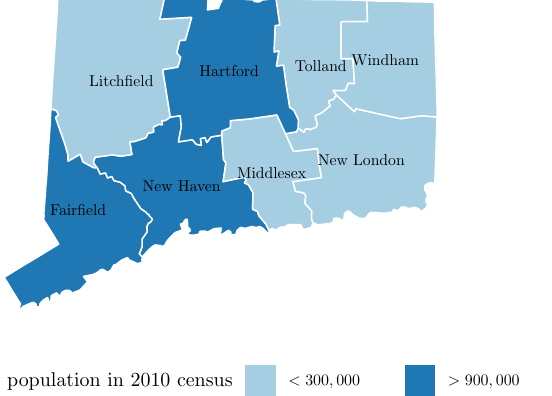
Figure 1. Subdivision of Connecticut into high-population and low-population counties Figure created using ggplot2 version 3.3.2 (https:// ggplo t2. tidyv erse.